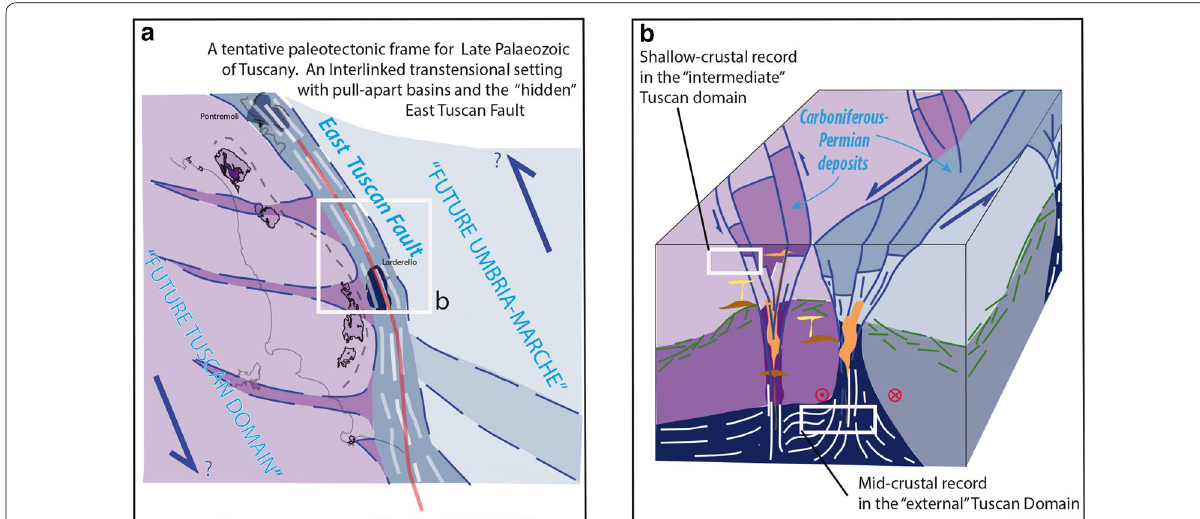
Fig. 12 a A tentative paleotectonic frame for late Palaeozoic in Tuscany showing the linked transtensional setting with pull-apart basins in the “intermediate” Tuscan domain and the “hidden” East Tuscan Fault whose remnants in terms of basement and cover may be found in subsurface in the northern (Pontremoli) and southern Tuscany (Larderello, Amiata). Also represented the possible trends of Permian basins in Tuscan and Umbria-Marche domains (Rau and Tongiorgi 1974; Scisciani et al. 2014); b geological sketch (not to scale) illustrating the inferred tectonic context of the late Palaeozoic tectonics in Tuscany. Pull-apart basins developed in splay structures of a major regional fault whose mid-crustal relict remnants may be found in Pontremoli and Larderello deep well with their Carboniferous-Permian cover in the M.Amiata subsurface